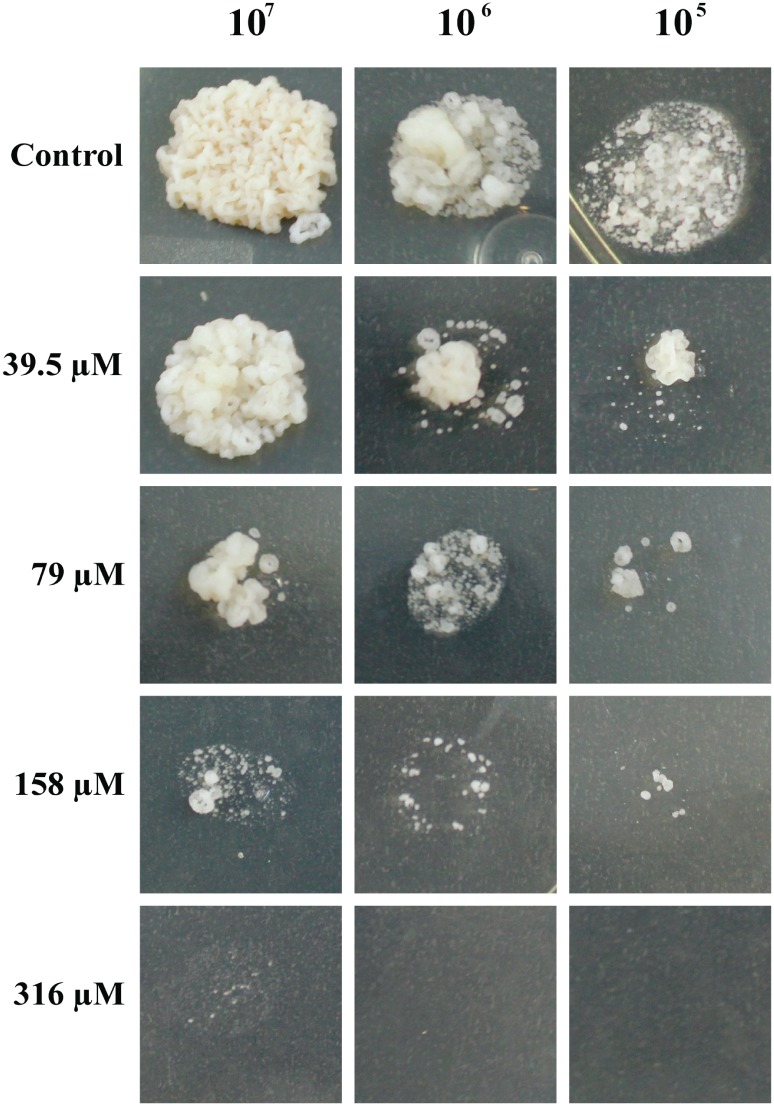
Susceptibility of P. lutzii yeast cells exposed to TSC-C.Samples containing 1x107, 1x106 and 1x105 yeast cells were spotted on Fava-Netto plates supplemented with TSC-C at the concentrations indicated above. The plates were incubated for 7 days at 36°C before photo documentation.